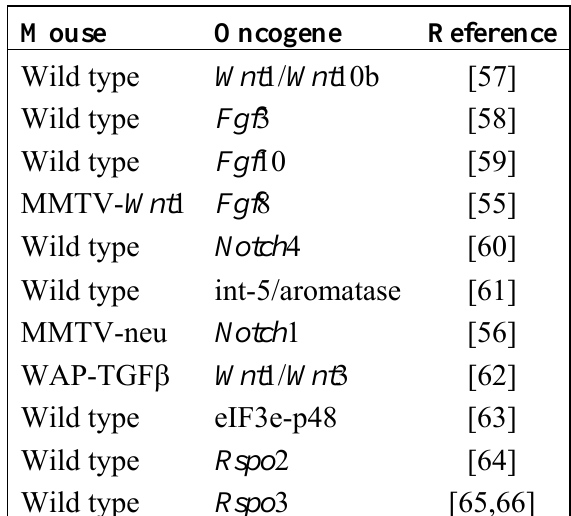
Table 1. MMTV common integration